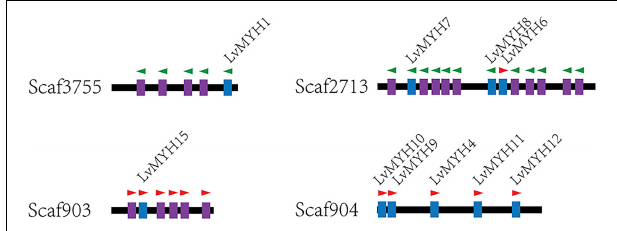
FIGURE 2 | Representation of paralogous muscle-type Myo2 gene clusters arranged on different scaffolds of L. vannamei . Blue: the complete muscle-type MYH gene. Purple: fragmental Myo2-like gene sequences or pseudogenes of MYH. The green and red triangles represent transcription orientation.